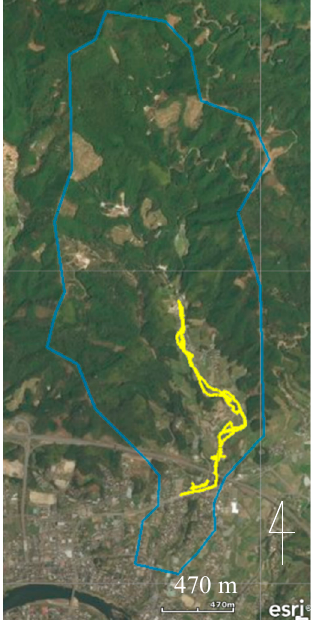
Figure 6. Survey route (yellow line) in the Shirakitani River Basin (blue line).